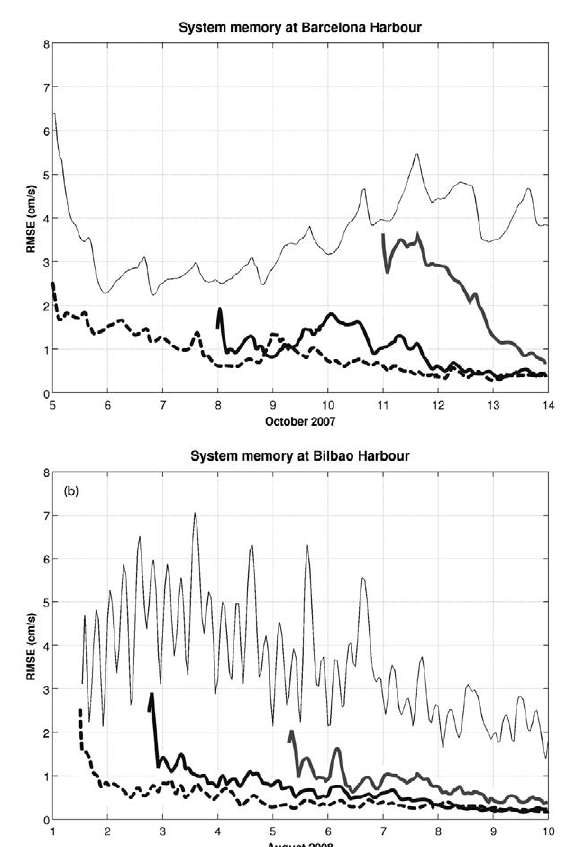
F ig . 2. – Time evolution for the RMSE (cm s –1 ) between the delayed and the reference (REF-BCN and REF-BIL) simulations for runs started on different dates. (a) Results for Barcelona harbour; dot- ted, black and grey lines correspond to runs started on 5, 8 and 11 October 2007, respectively. (b) Results for Bilbao harbour; dotted, black and grey lines correspond to runs started approx. on 1, 3 and 5 August 2008, respectively. The time evolution of the mean current (cm s –1 ) within the harbours (black thin lines) is also